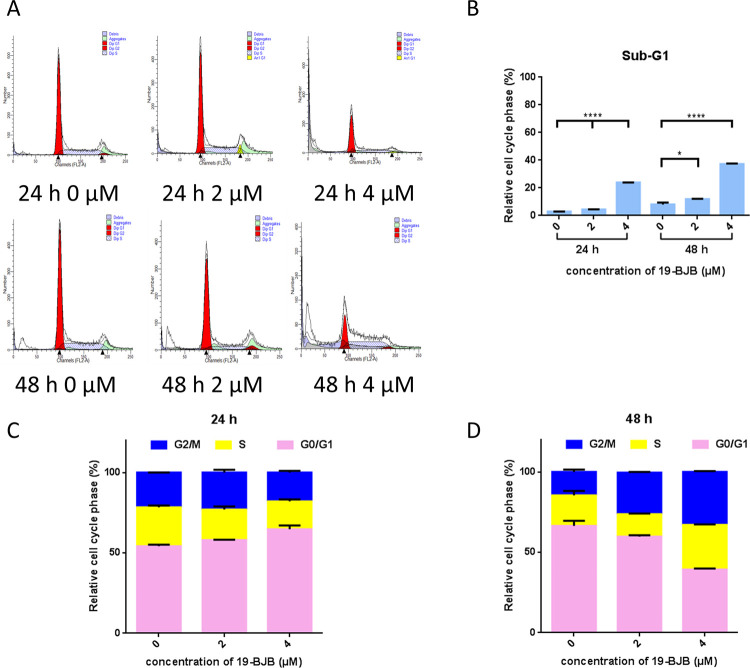
19-BJB induces cell cycle arrest in T24 cells.(A) FACS analysis data of T24 cell cycle. Samples were analyzed on a BD FACScan flow cytometer and the percentage of cells in the Sub-G1, G0-G1, S, and G2-M phases of the cycle was determined using FACS Express V3. (B) The change of Sub-G1 phase in FACS analysis affected by 19-BJB. (C) T24 cells treated with 19-BJB (0, 2, 4 μM) for 24 h. (D) T24 cells treated with 19-BJB (0, 2, 4 μM) for 48 h. The data are expressed as means ± SD from triplicate samples for each treatment. *p < 0.05, ****p < 0.0001.